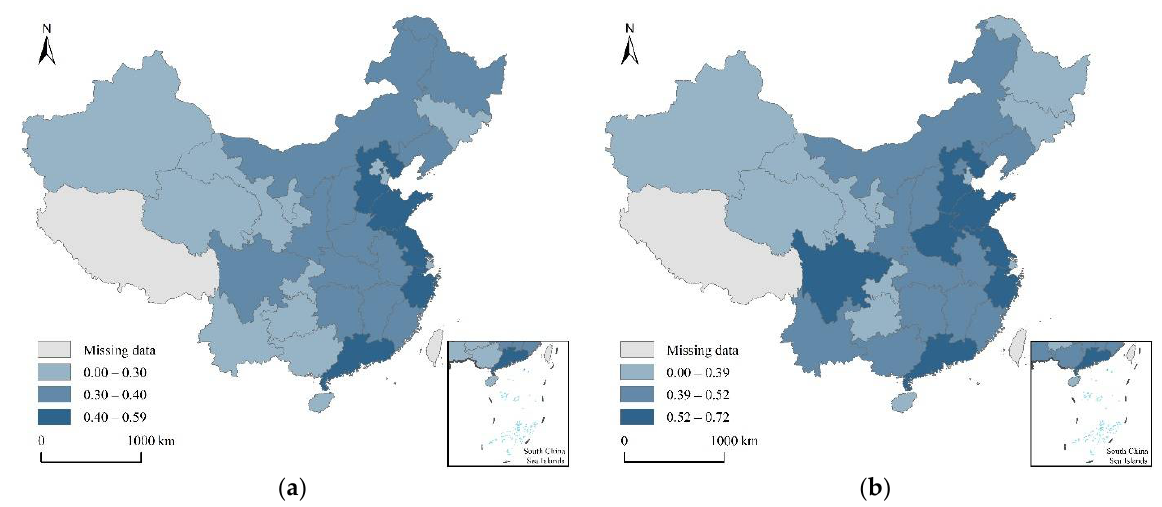
Figure 5. The distribution of integrated infrastructure in 2013 and 2020. ( a ) 2013; ( b ) 2020.